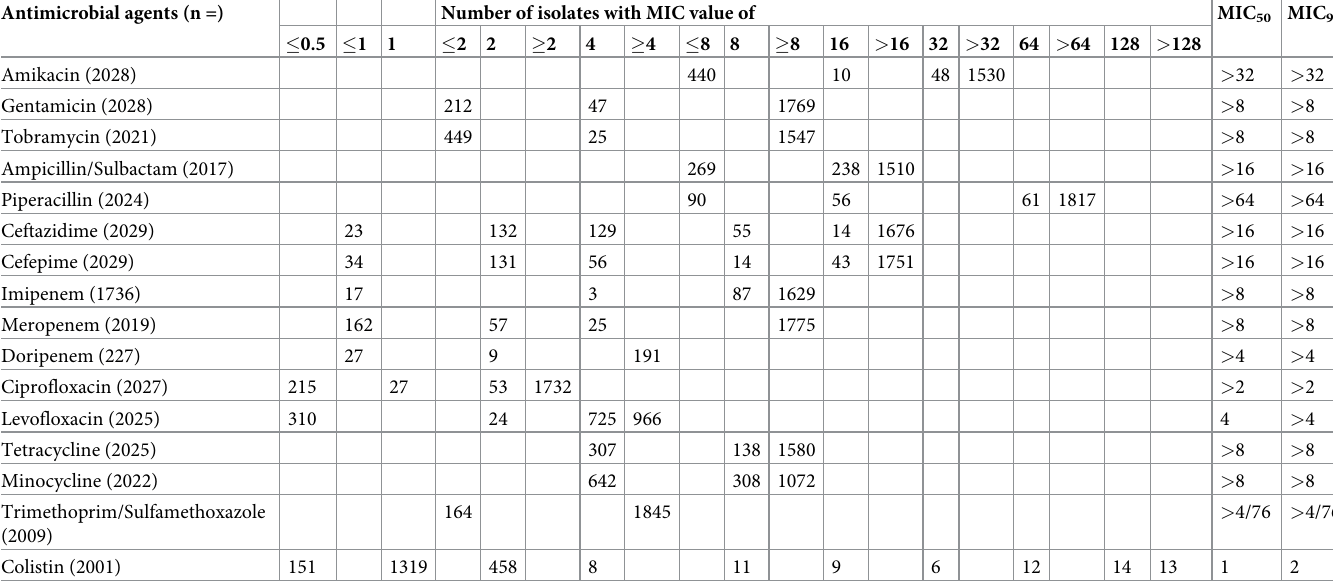
Table 4. Antimicrobial minimum inhibitory concentration distribution of Acinetobacter baumannii complex (ABC) bloodstream isolates from South Africa from 1 April 2017 to 30 September 2019. Antimicrobial agents (n =) Number of isolates with MIC value of MIC 50 MIC